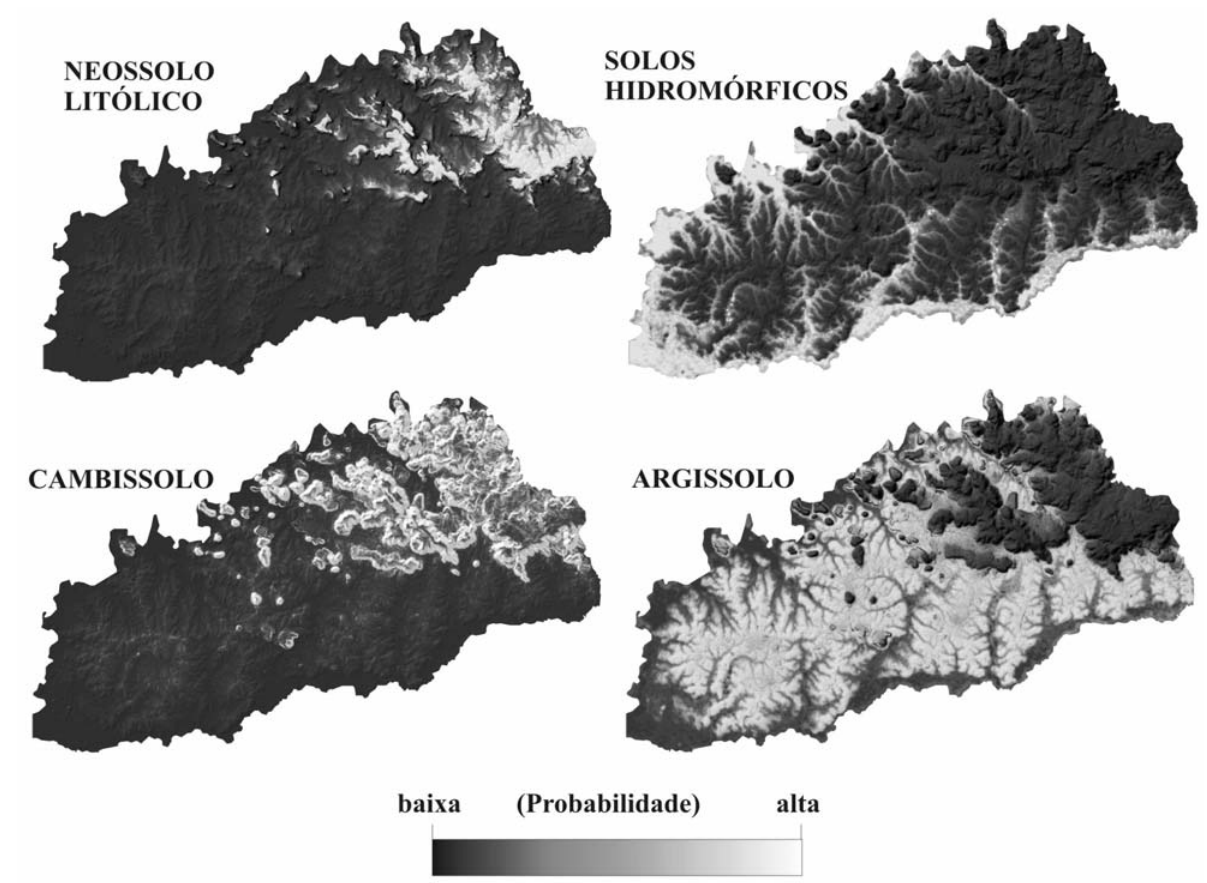
Figura 2. Mapas de probabilidade de ocorrência das classes de solos em nível de ordem na área de